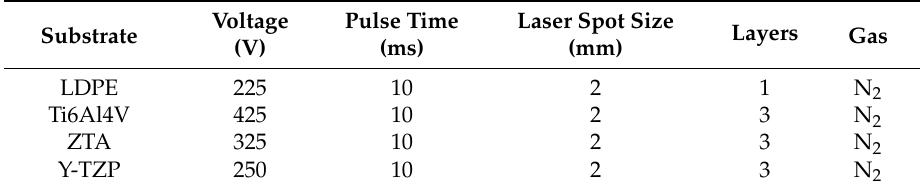
Table 1. Deposition parameters for various substrates. LDPE, low-density polyethylene;